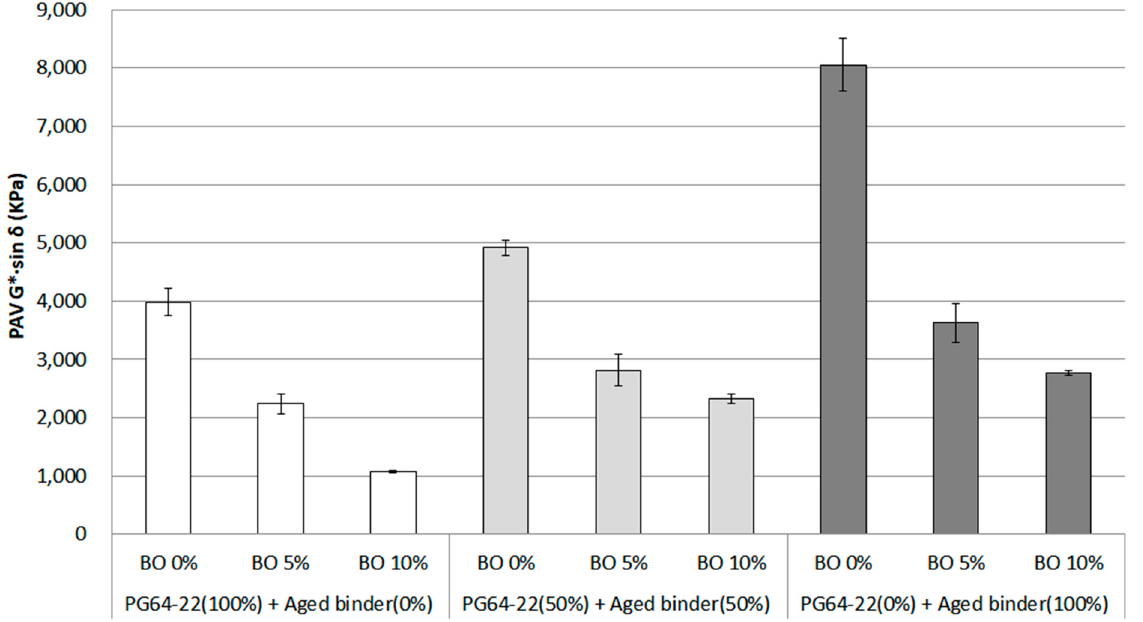
Figure 7. G*·sin δ of each asphalt binder containing the base oil for RTFO + PAV condition. Figure 7. G* · sin δ of each asphalt binder containing the base oil for RTFO + PAV